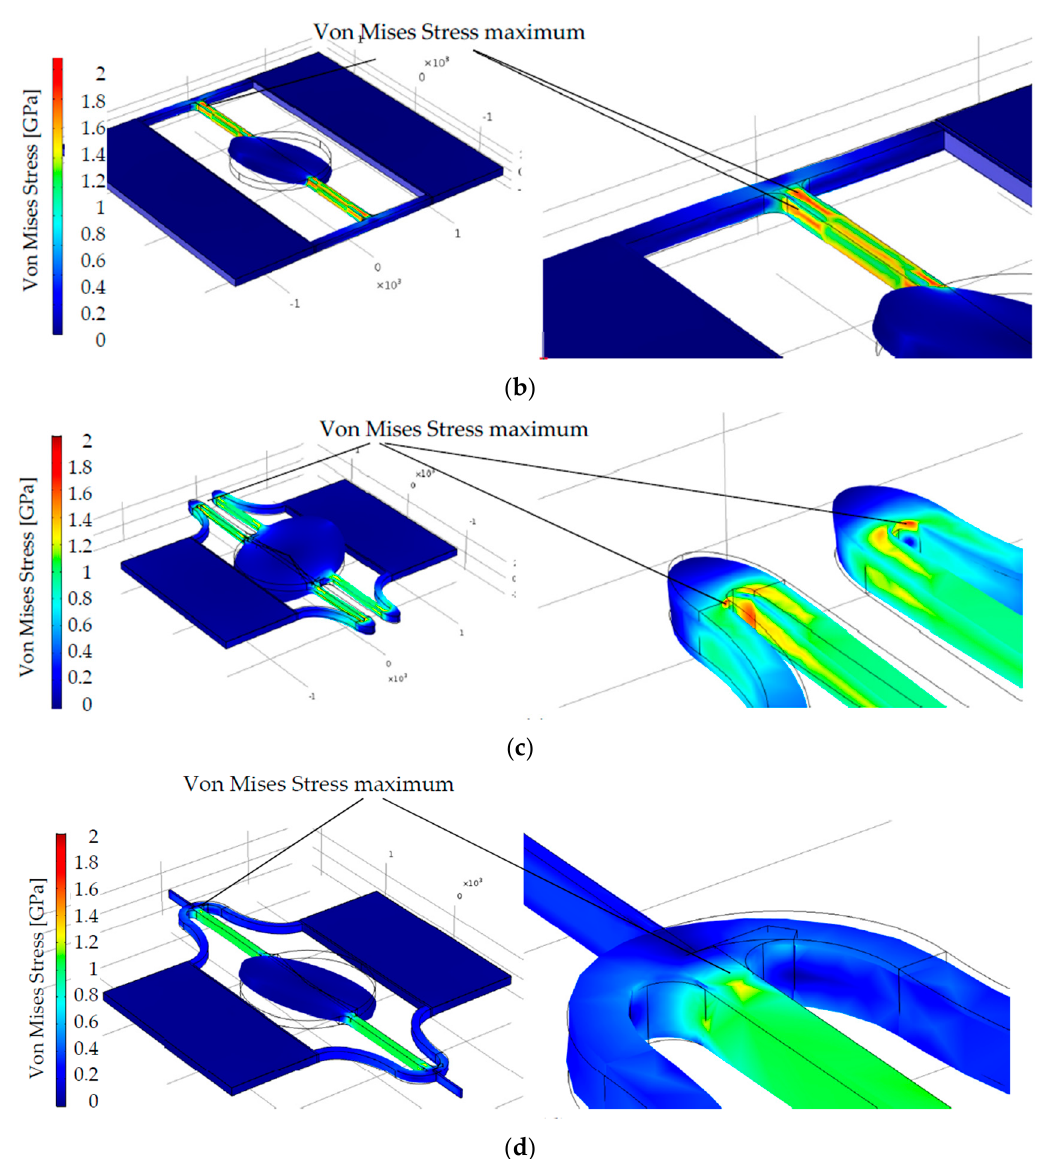
Figure 5. Different maximum Von Mises Stresses in different mirrors, when these mirrors achieve a same mechanical tilting angle of 15°: ( a ) Von Mises stress maximum of 1.8 GPa in design S1; ( b ) Von Mises stress maximum of 1.8 GPa in design S2; ( c ) Von Mises stress maximum of 1.6 GPa in design E5; ( d ) Von Mises stress maximum of 1.4 GPa in design E4.